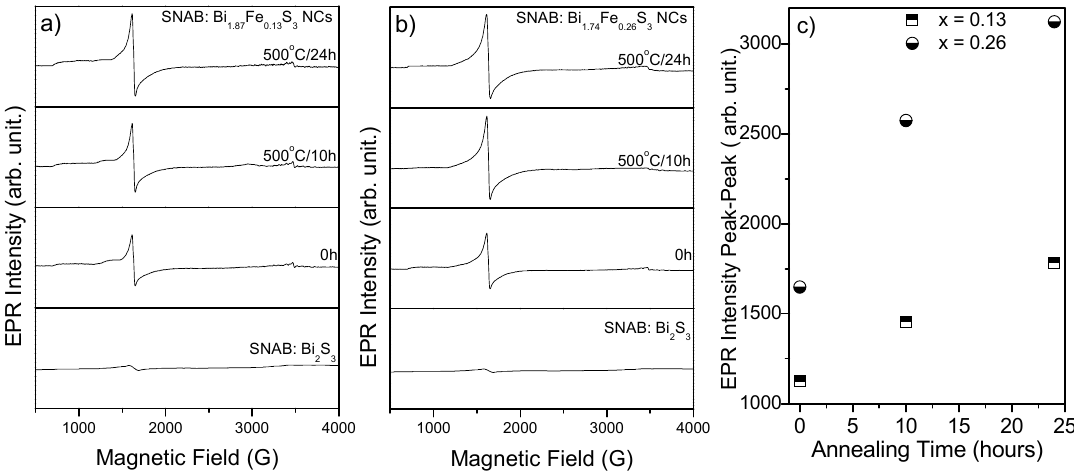
Figure 3. Bi 2 − x Fe x S 3 nanocrystal EPR spectra grown in the SNAB glass matrix for: ( a ) x = 0.13 and ( b ) x = 0.26. SNAB: Bi 2 S 3 is correspondent to the case where x = 0.00. In ( c ), the intensity variation of the EPR signal is shown for the samples without treatment and with treatment times of 10 and 24 h at 500°C.